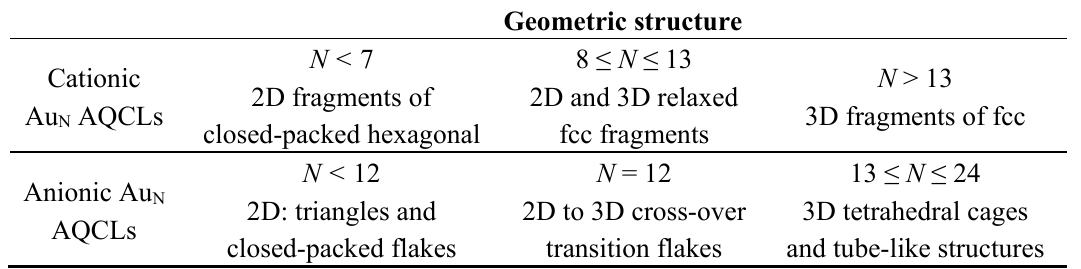
Table 3. Compilation of theoretical results [28] obtained for isomer geometries in free Au